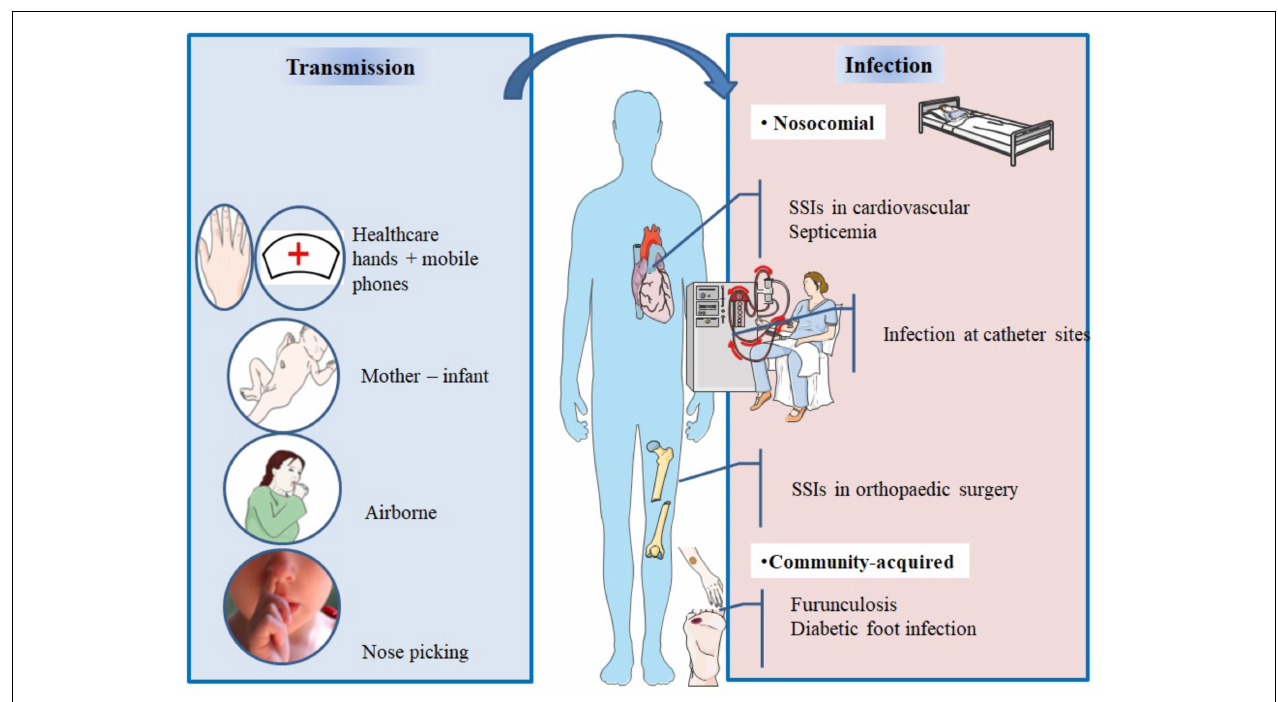
FIGURE 2 | Main spread and transmission mechanisms of S. aureus and impact of nasal carriage on subsequent